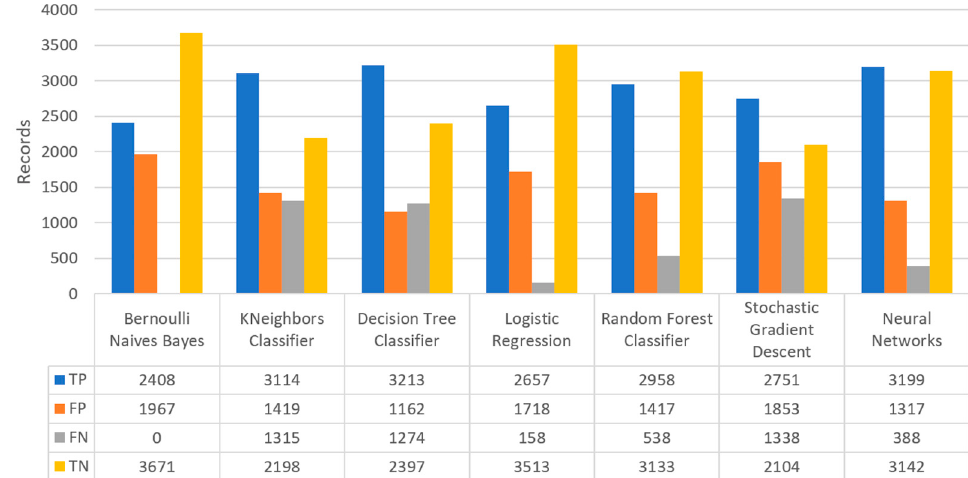
Figure 16. Confusion matrix of prediction results for diabetes use case.